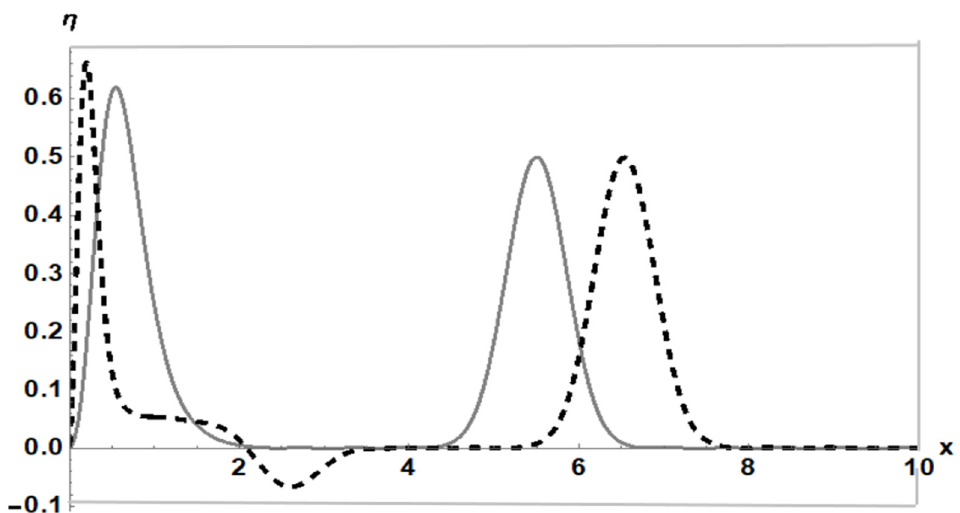
Figure 5. The shape of the wave at 𝑡 = 2.5 for the smooth beach is 𝛼 = 1 (solid line), and for the beach with the vertical step, 𝛼 = 0.5 (dashed line).